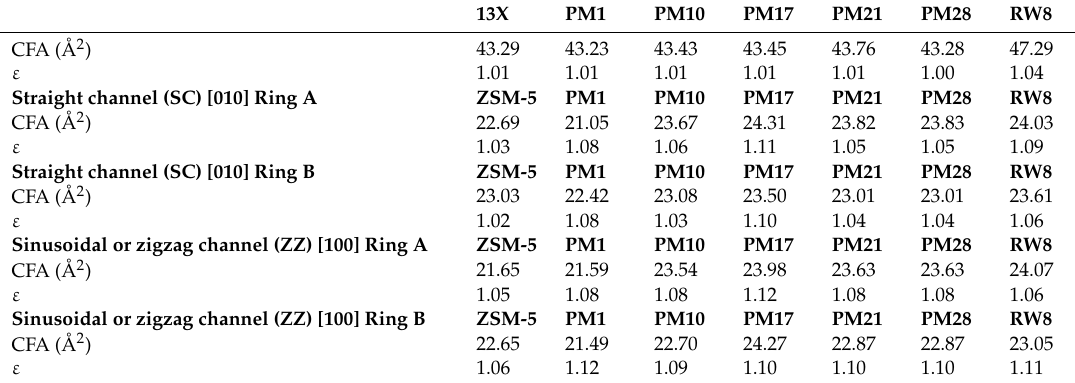
Table 5. Crystallographic Free Area (CFA) and channel ellipticity ( ε ) for ZSM-5 and 13X before and after adsorption.